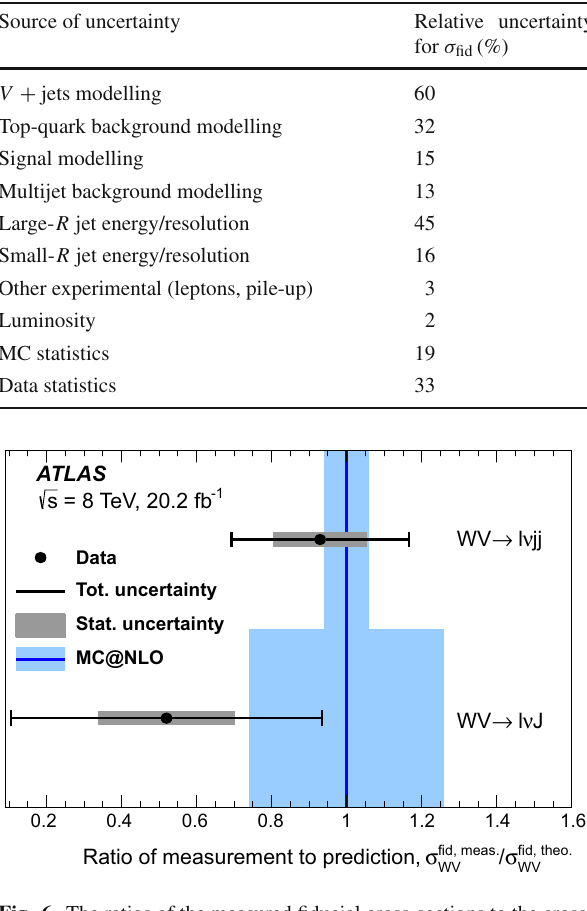
Fig. 6 The ratios of the measured fiducial cross-sections to the cross- sections predicted by MC@NLO, for the WV → (cid:4)ν jj and WV → (cid:4)ν J phase spaces. The WV → (cid:4)ν jj and WV → (cid:4)ν J phase spaces partially